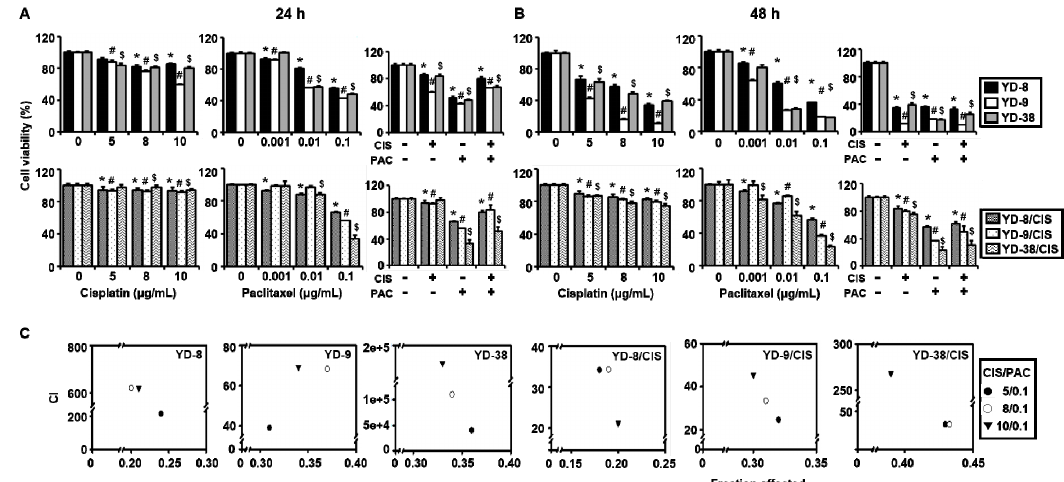
Figure 1. Cisplatin and paclitaxel used in combination had no synergistic effect in oral squamous cell carcinoma (OSCC) cancer cell lines. ( A , B ) Cells were treated with cisplatin (0–10 μ g/mL) or paclitaxel (0–0.1 μ g/mL) for 24 and 48 h. After 24 h, cell growth of these cancer cell lines was more inhibited by paclitaxel (0.1 μ g/mL) alone than by cisplatin (10 μ g/mL) alone or by combined treatment. The effect of cisplatin with or without paclitaxel on the viability of YD-8, YD-9, YD-38, YD-8/CIS, YD-9/CIS, and YD-38/CIS cells was determined by MTT assay (mean ± SD; n = 6). * p < 0.05 versus non-treated group in YD-8 or YD-8/CIS cells, # p < 0.05 versus non-treated group in YD-9 or YD-9/CIS cells, and $ p < 0.05 versus non-treated group in YD-38 or YD-38/CIS cells. ( C ) There was no synergistic effect. A fraction- affected versus CI plot (CIS/PAC) was determined using the Chou-Talalay and CompuSyn software.